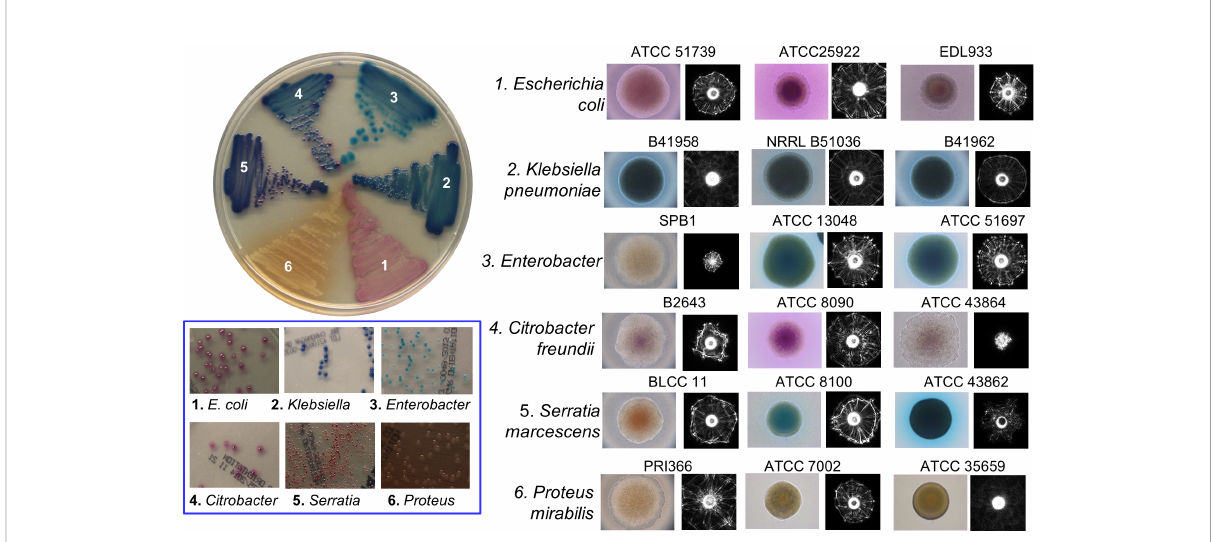
FIGURE 5 Microscopic images of colonies and corresponding scatter patterns of bacteria from Enterobacteriaceae family grown on CHROMagar ™ Orientation medium. Source (Singh and Bhunia,